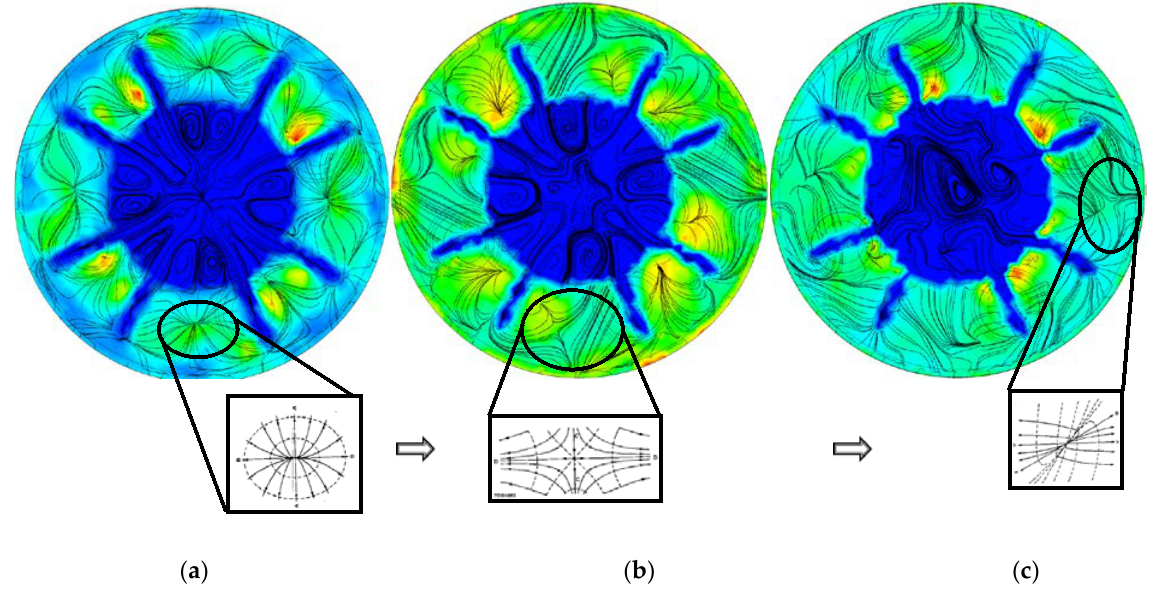
Figure 4. Rearrangement of the flow structure near the impermeable end of the PP channel: black lines are current lines, color counter is a field of heat transfer coefficient (minimal is a blue color, maximal is a red color), where ( a ) for time 0.0001[s], ( b ) for time 0.0002–0.0005[s],( c ) for time 0.0006–0.001[s].